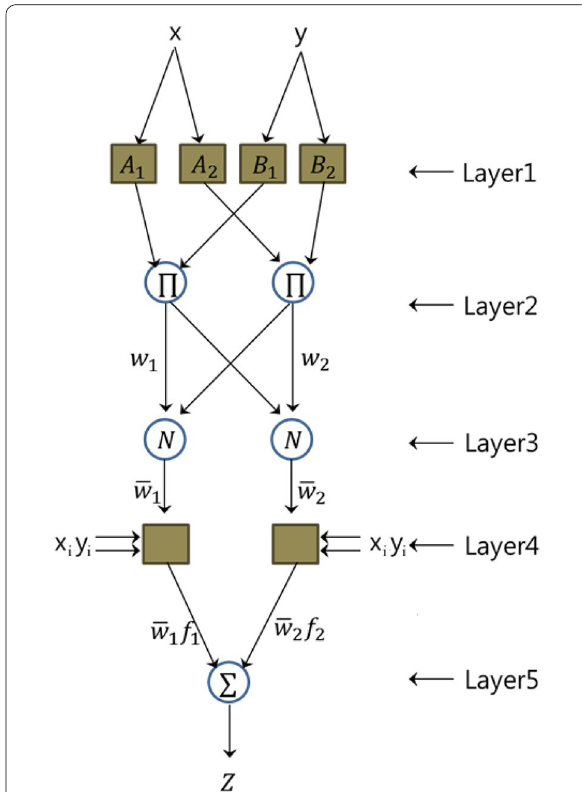
Fig. 2 Conceptual Organization of the ANFIS.